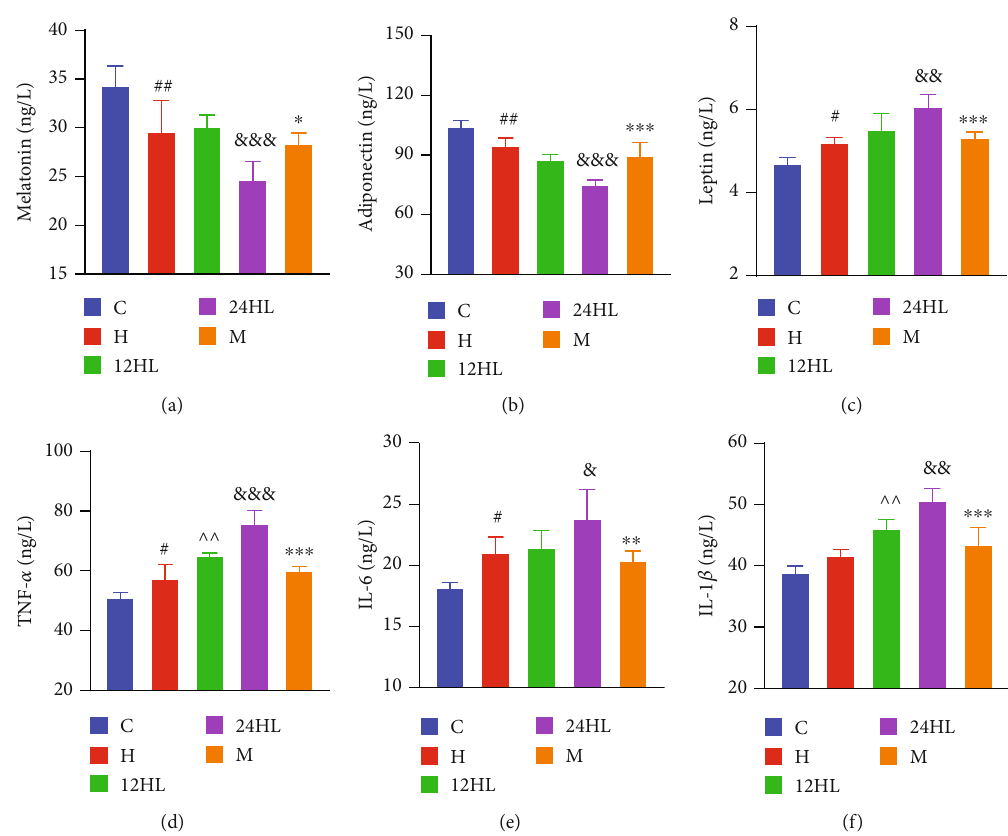
Figure 4: E ff ect of melatonin on endocrine hormones and in fl ammation. (a) Melatonin, (b) adiponectin, (c) leptin, (d) TNF- α , (e) IL-6, and (f) IL-1 β after treatment (on week 10). C: control group; H: HFD group; 12HL: 12 h light group; 24HL: 24 h light group; M: melatonin group. The values are expressed as the means ± S : D : ( n = 6 -8 per group). # P < 0 : 05 and ## P < 0 : 01 , HFD vs. control; ^^ P < 0 : 01 , 12HL vs. HFD group; & P < 0 : 05 , && P < 0 : 01 , and &&& P < 0 : 001 , 24HL vs. 12HL group; ∗ P < 0 : 05 , ∗∗ P < 0 : 01 , and ∗∗∗ P < 0 : 001 , M vs. 24HL